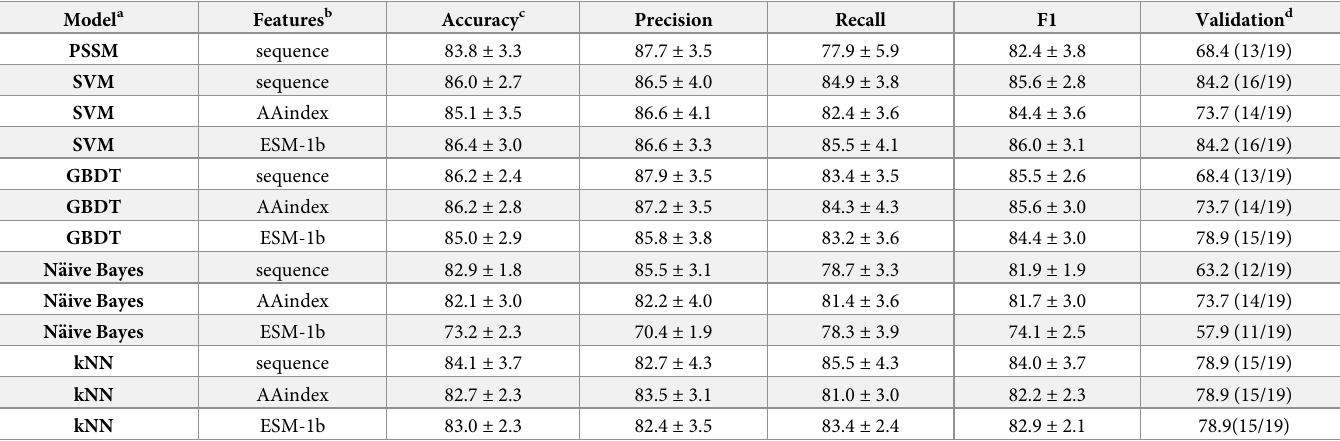
Table 1. Performance of various models for prenylation prediction.